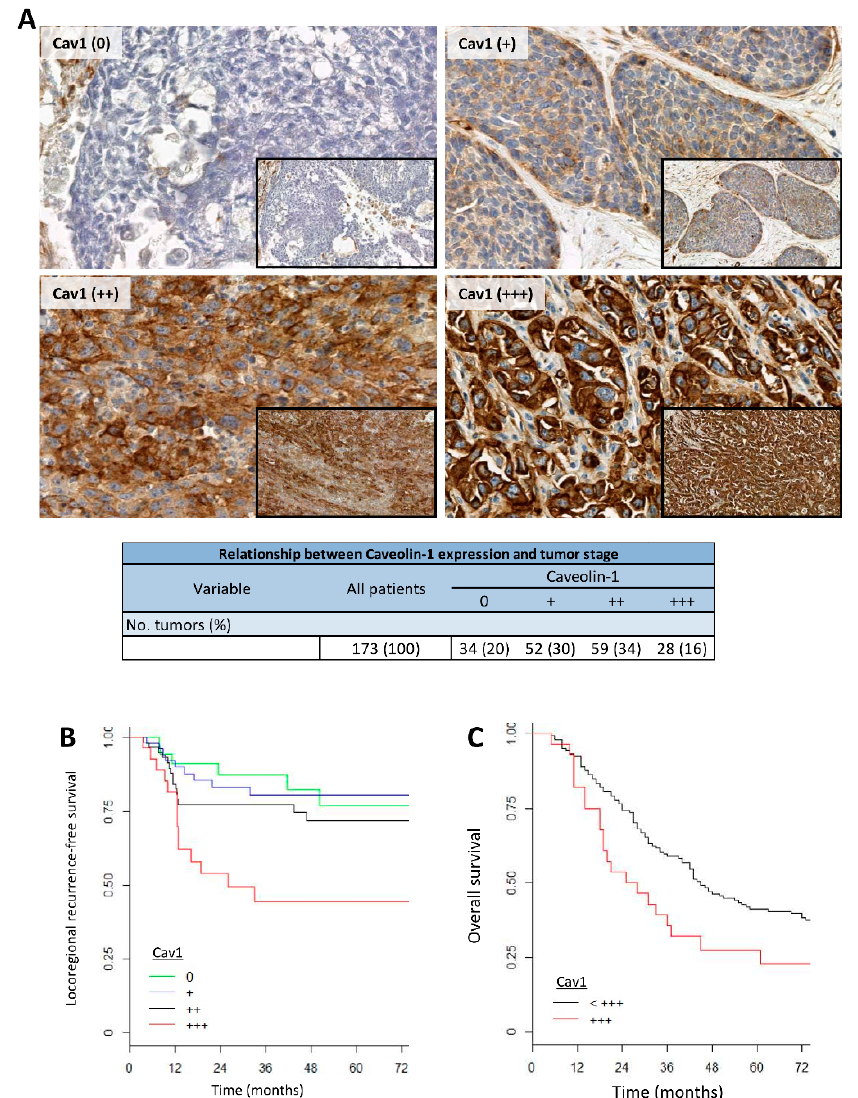
Figure 6. Cav1 expression in human HNSCC primary tumor tissues. ( A ) Semiquantitative analysis of the immunohistochemical staining of Cav1 based on classification in 4 categories according to the percentage of Cav1-positive carcinoma cells: 0: 0%; +: 1–25%; ++: 26–75%; +++: > 75% (original magnification: × 10 and × 40). ( B ) Locoregional recurrence-free survival. ( C ) Overall survival was analyzed according to Cav1 protein expression using the Kaplan–Meier estimate with the log rank test. Thirty-four tumors (20%) did not express Cav1 (Cav1 (0)). The remaining 80% ex-